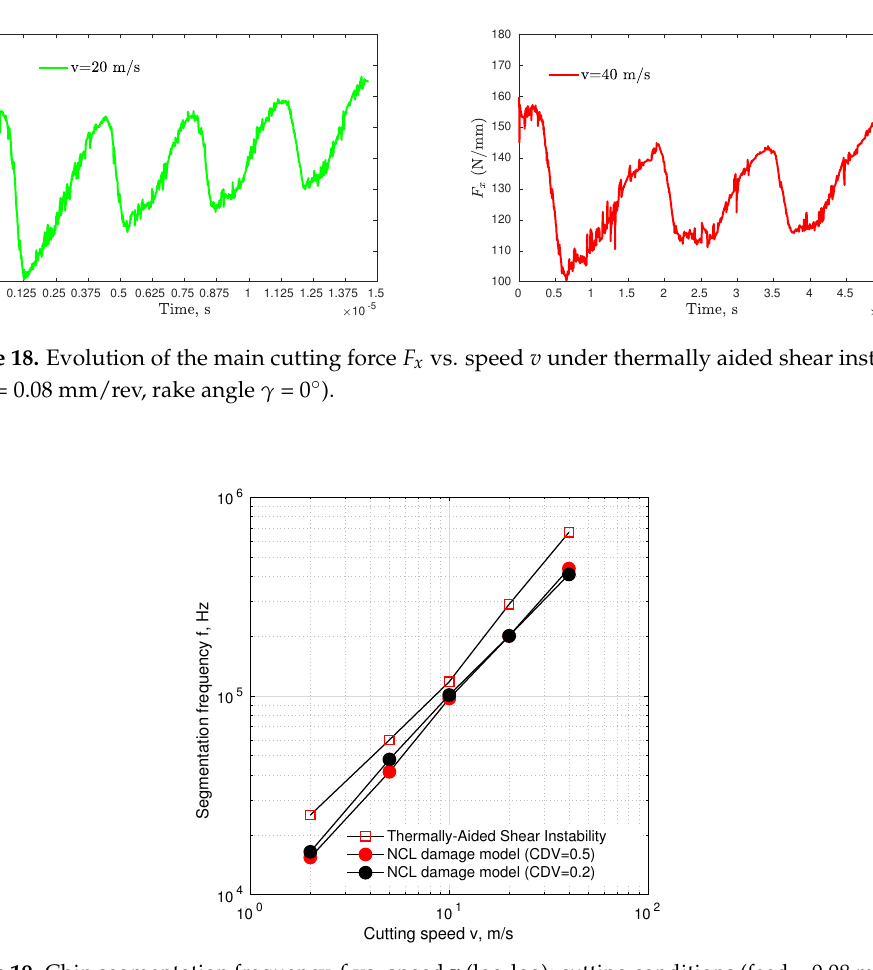
Figure 19. Chip segmentation frequency f vs. speed v (log-log); cutting conditions (feed = 0.08 mm/rev, rake angle γ = 0 ◦ ). The slope in the investigated cutting speed regime is approximately ≈ 1 and indicates that f ∝ v for both models. The segmentation frequency slope remains unaffected by the change of